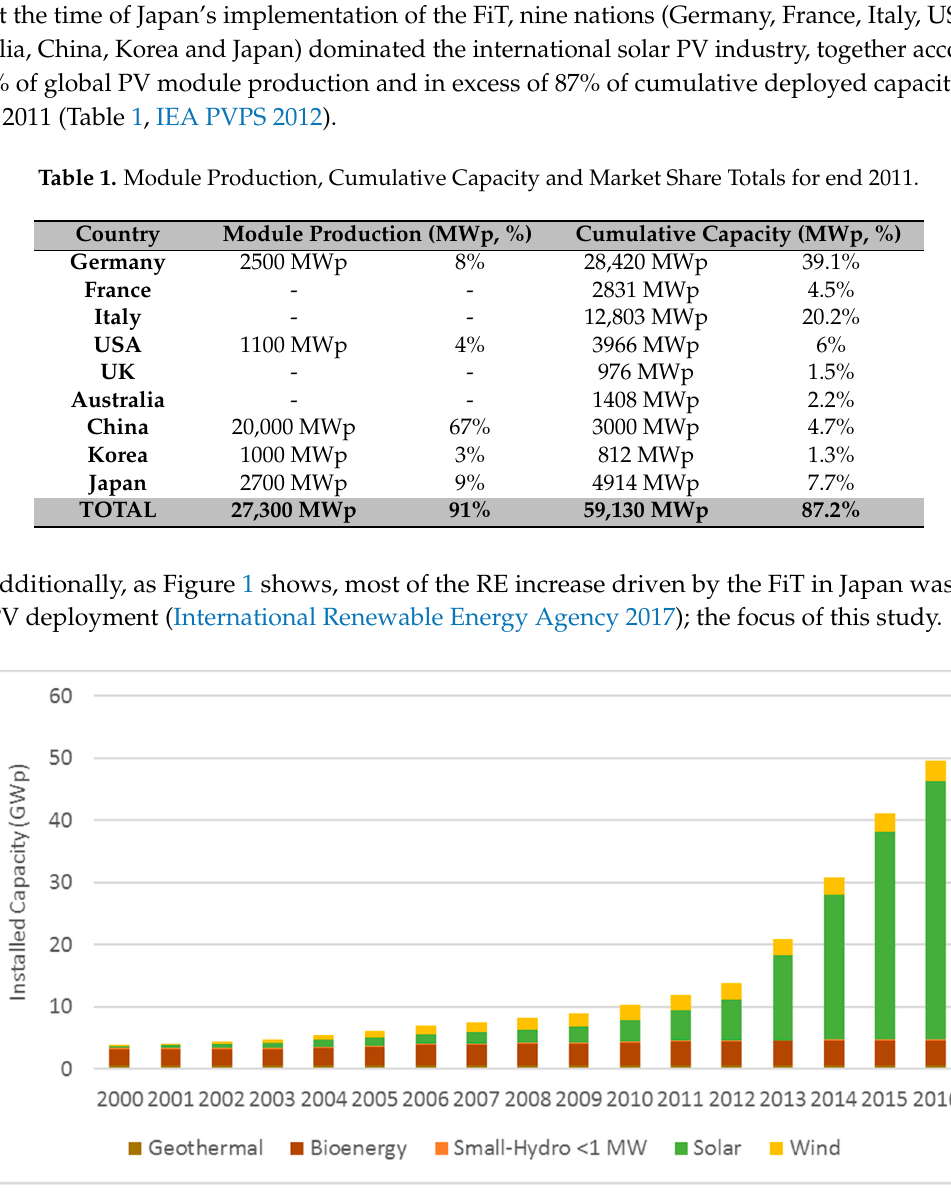
Figure 1. Cumulative Installed Capacity of Renewable Energy in Japan 2000–2016.